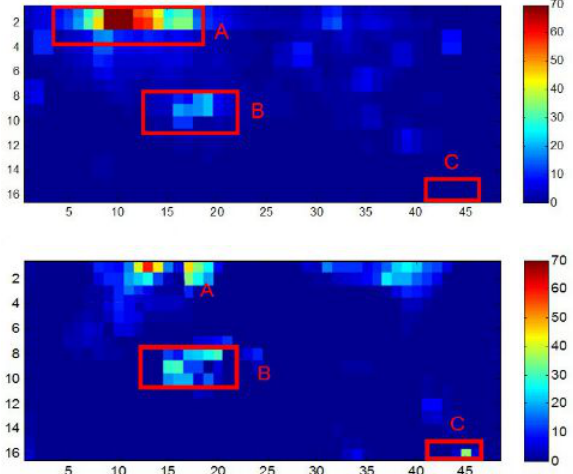
Figure 3. The simulated vs observed thermal habitat occupancy of a